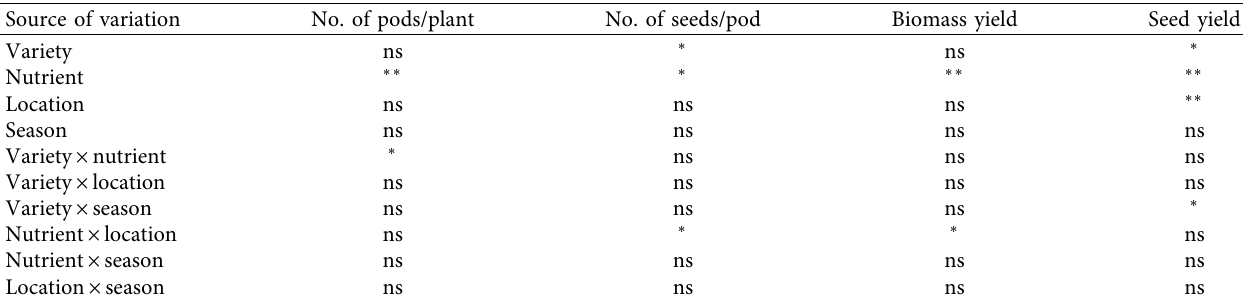
Table 3: Analysis of variance for treatment effects and their interactions on number of pods per plant, number of seeds per pod, biomass yield, and seed yield.